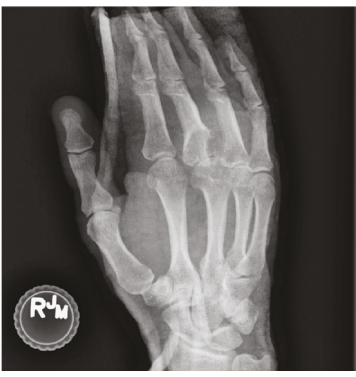
Figure 1: Oblique radiograph of the right hand demonstrating a lytic destructive process of the base of the proximal phalanx, third digit.